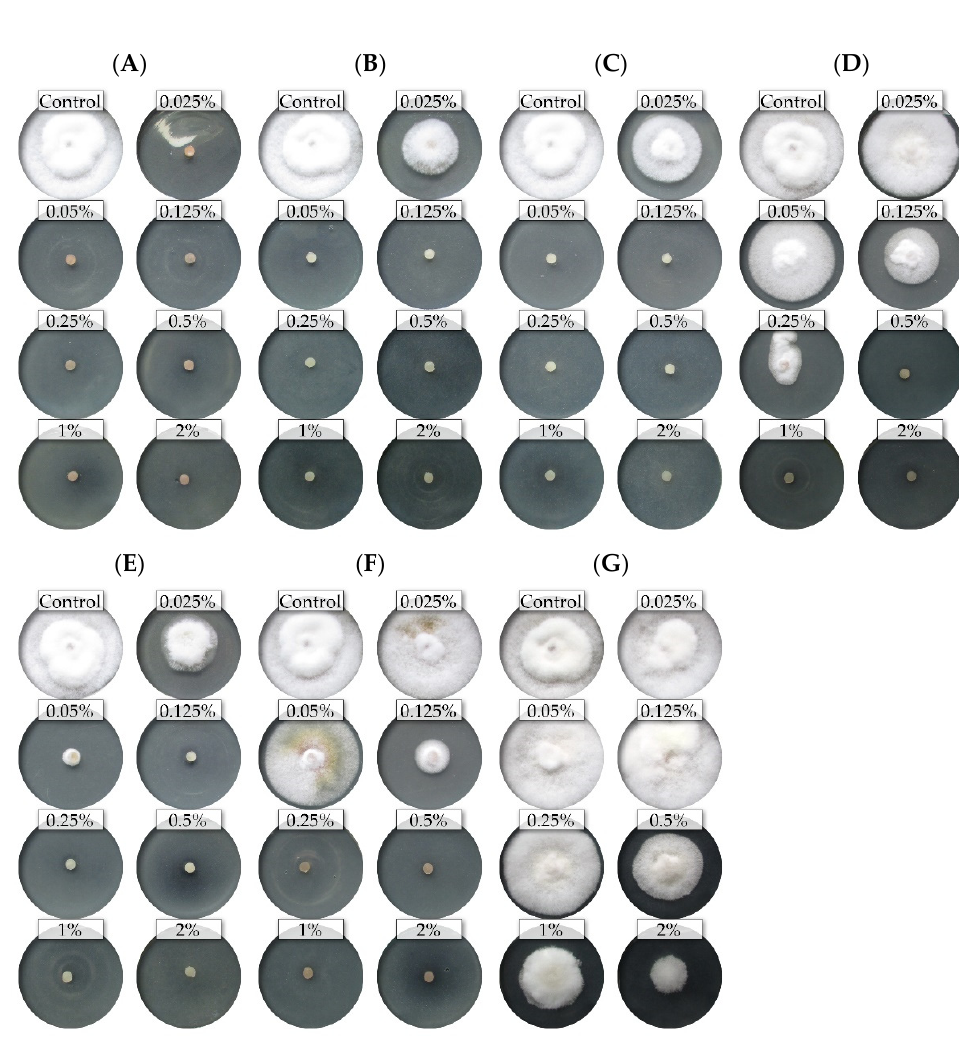
Table 1. Results of Kruskal–Wallis test. Comparison of the index of linear growth of mycelial isolate in presence of used essential